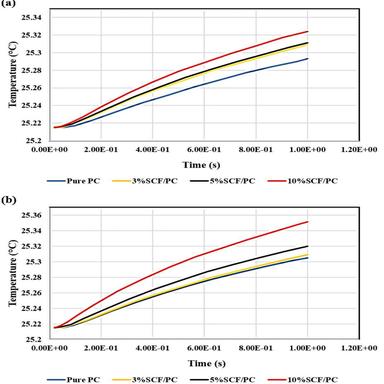
Variation of temperature w.r.t time for samples printed in (a) 0◦XY-plane (b) 90◦ XY-plane for different SCF percentage.